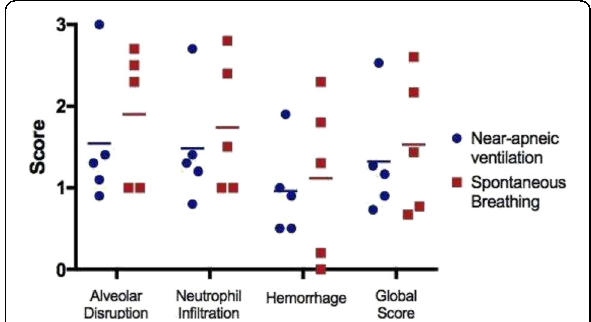
Fig. 1 (abstract 0435). Histological Lung Injury Score. Scored from 0= no alteration to 3= maximal injury